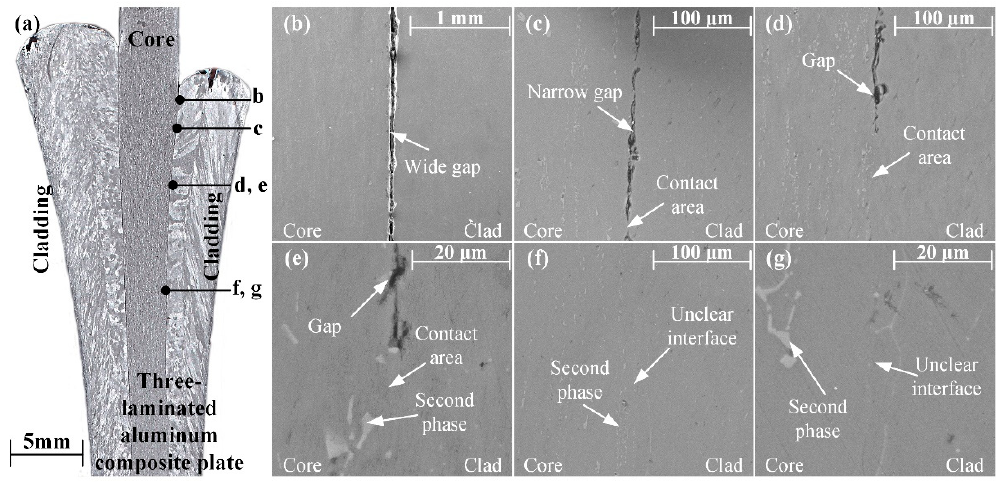
Figure 15. Evolution process of interface of LSL-TRC.